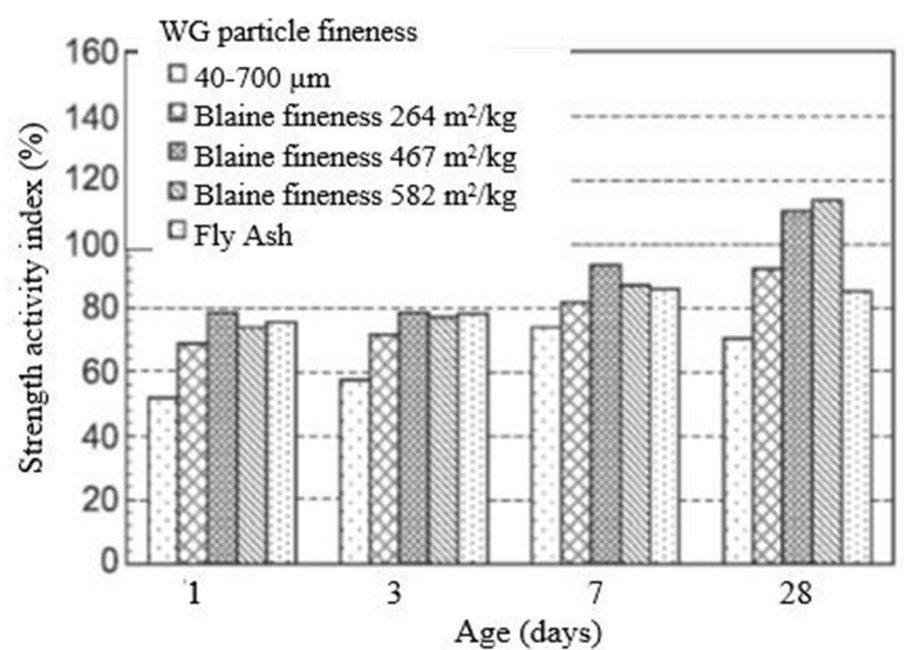
Figure 3. Strength activity index of WG powder with varying fineness